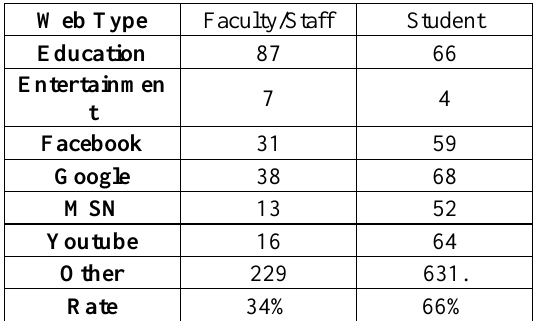
Table 2. User Ratio of